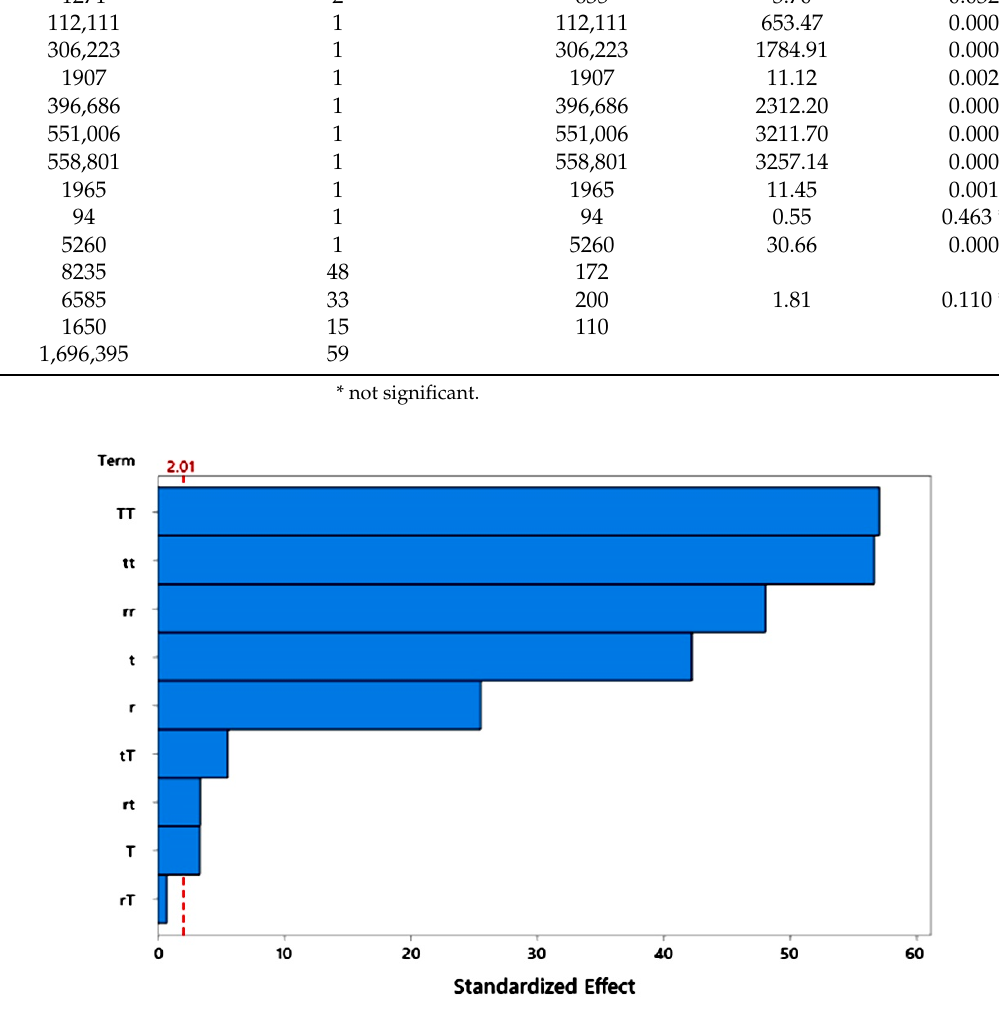
Figure 4. Pareto chart of the standardized effects of the independent parameters on the synthesis of ZIF-L, as measured by the 𝑞 response.